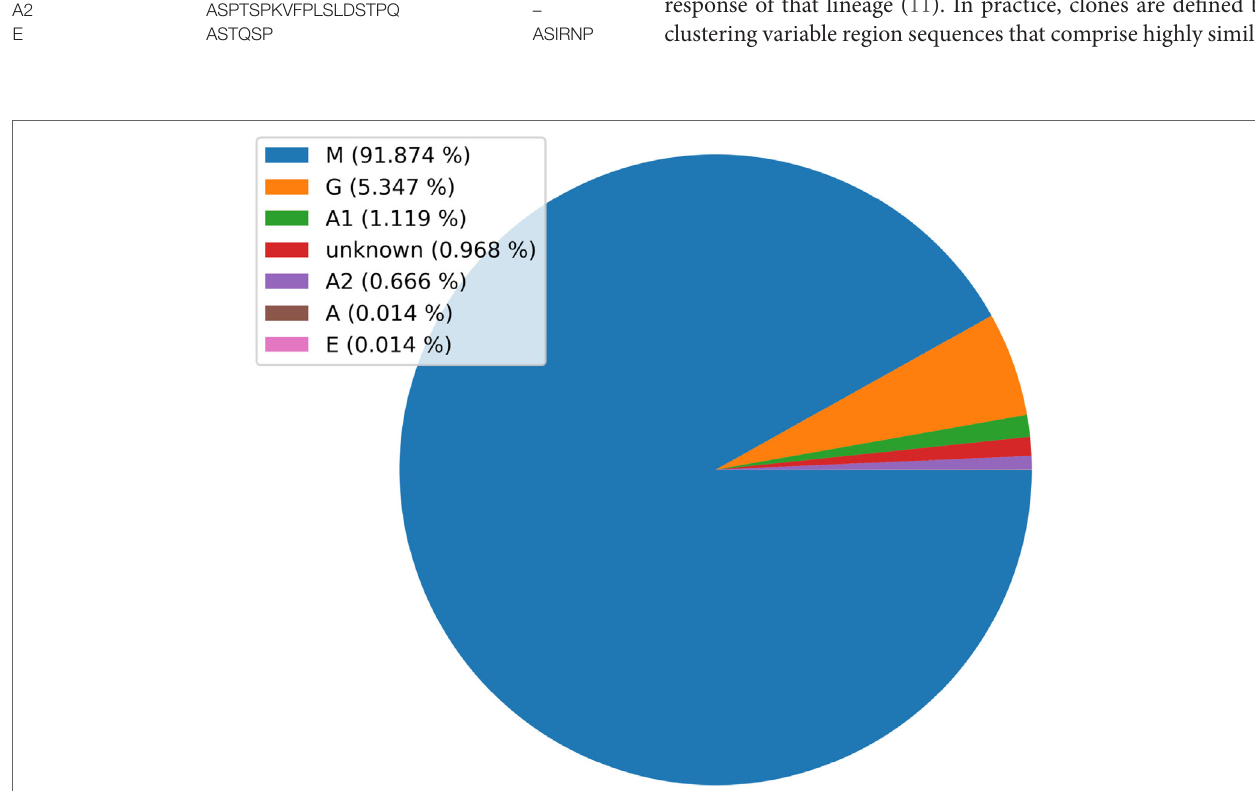
FIguRe 3 | A pie chart showing the distribution of isotypes in a specific next-generation sequencing (NGS) replicate. Note, this chart was generated using unpublished human NGS data.